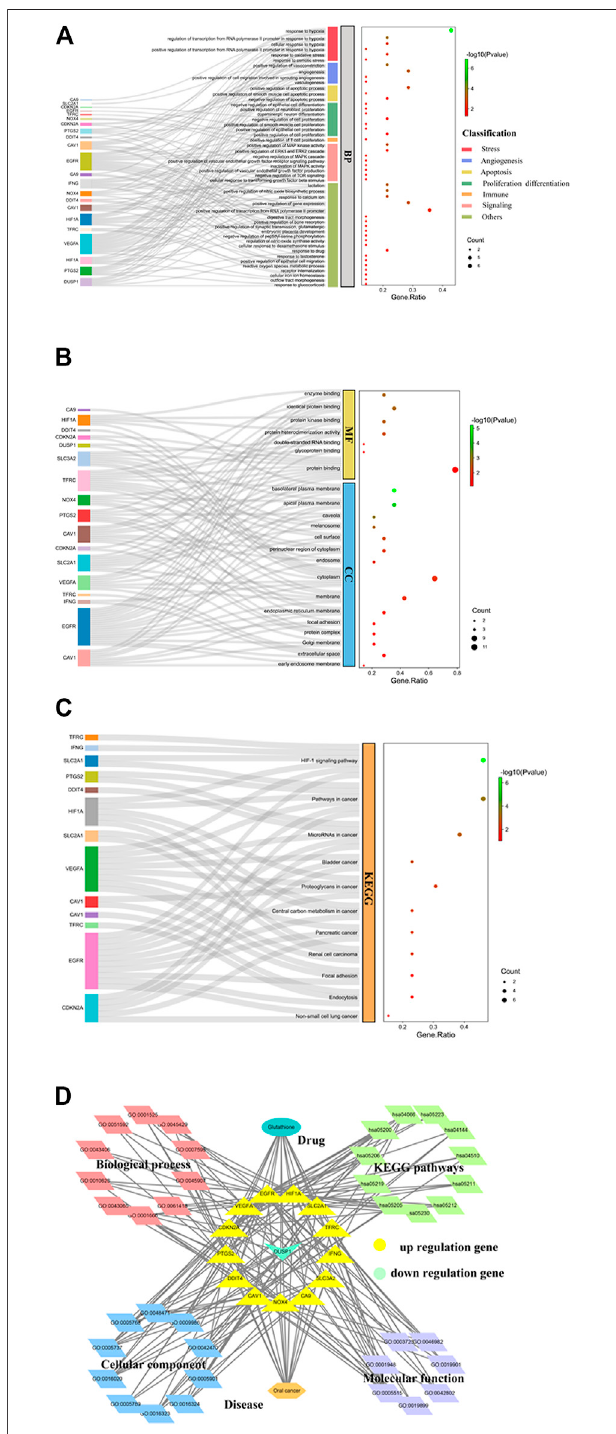
FIGURE 2 | Functional characterization of glutathione (GSH)-targeting ferroptosis genes in oral cancer (OC). (A) Gene Ontology (GO) enrichment analysis highlighting the biological roles of GSH-targeting ferroptosis genes in stress responses, angiogenesis, apoptosis, cell proliferation, cell differentiation, immune responses, and cell signaling for treating OC. (B) GO enrichment analysis highlighting the molecular functions and cellular